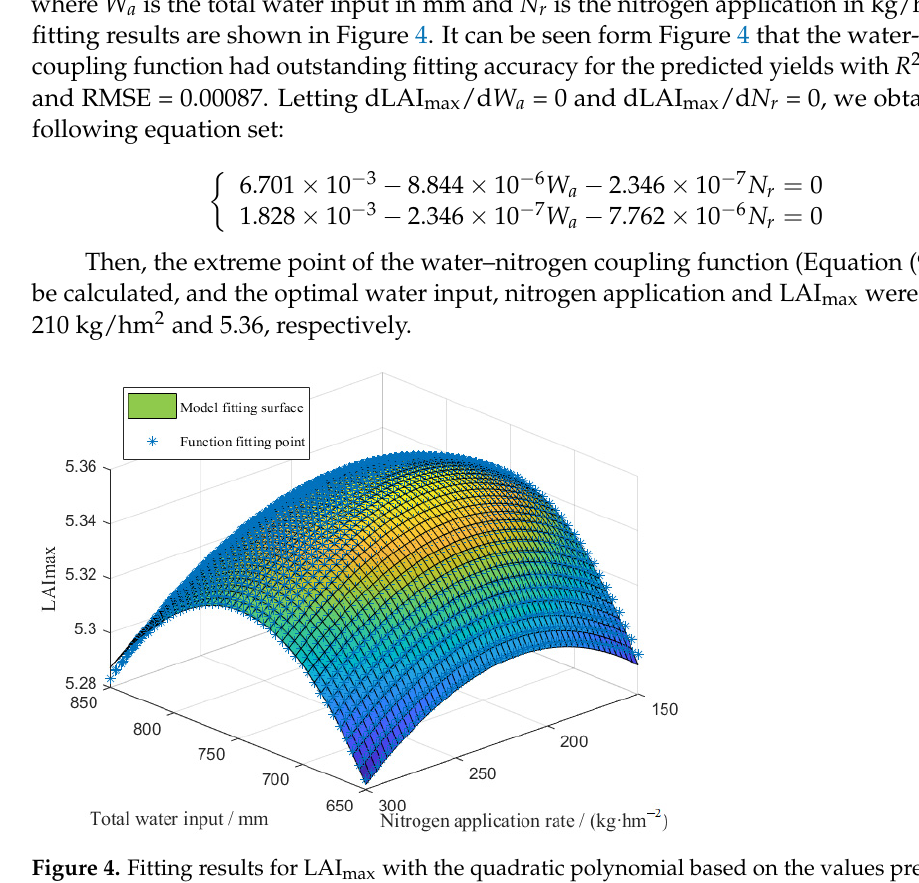
Figure 4. Fitting results for LAI max with the quadratic polynomial based on the values predicted by Gaussian regression model.